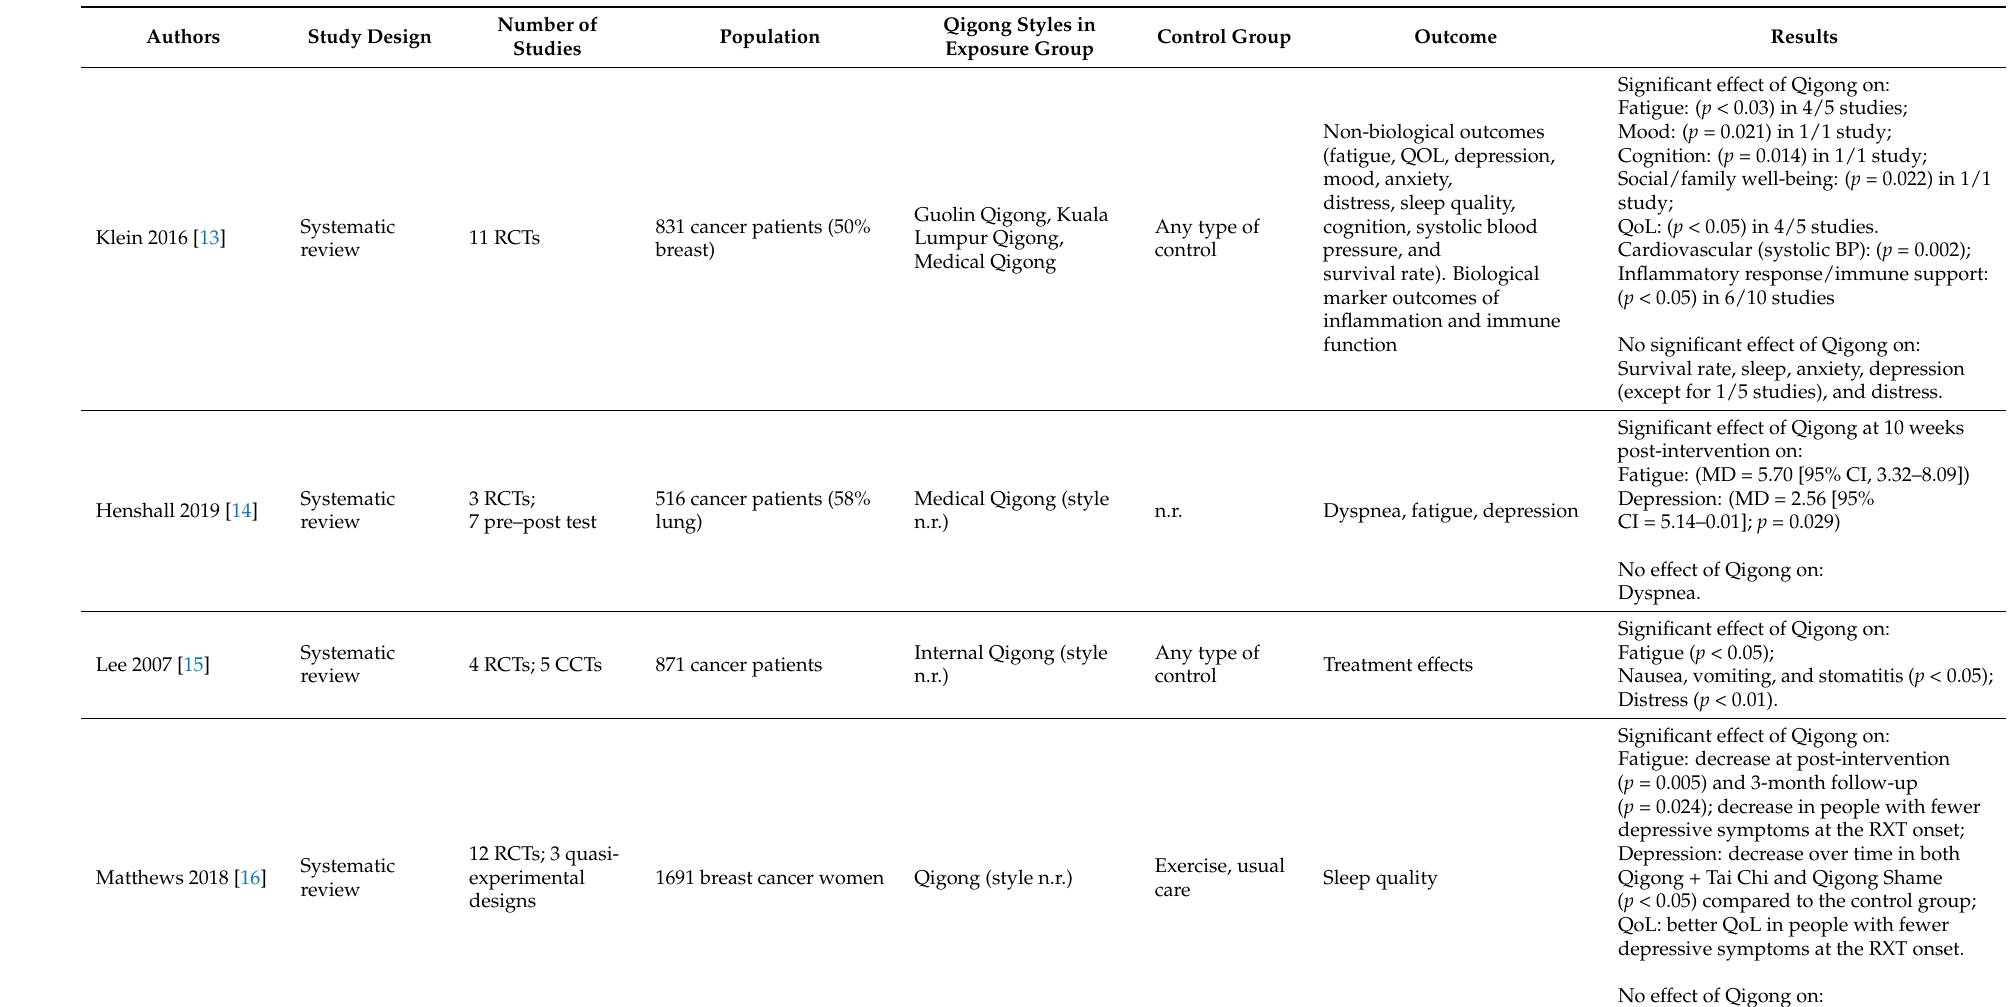
Table 1. Descriptive summary of secondary studies included in the umbrella review (n